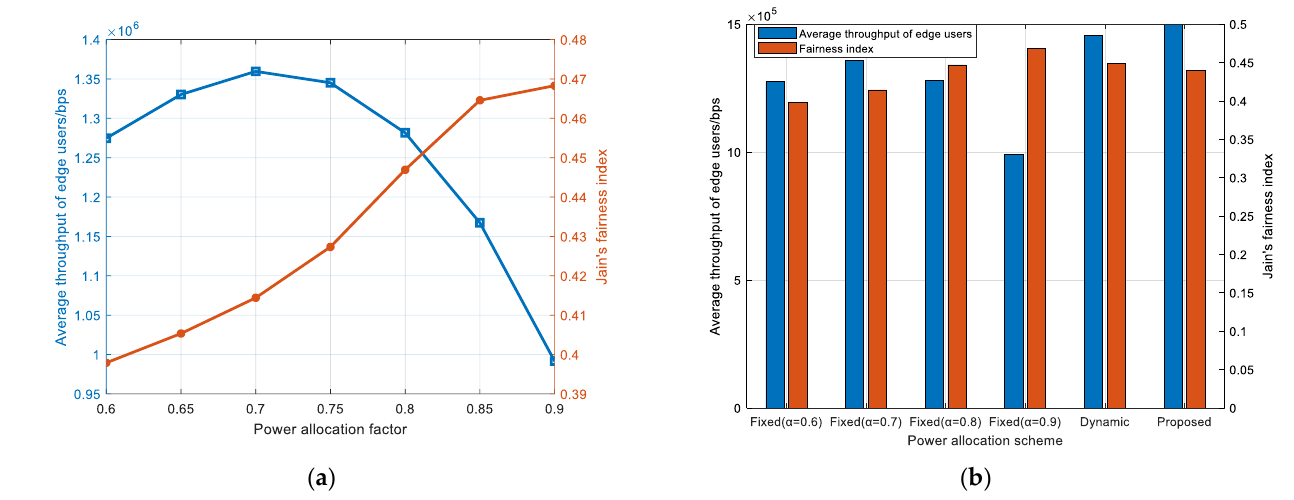
Figure 4. Throughput performances of edge users and fairness index: ( a ) under random user pairing scheme with different power allocation factor; ( b ) under different power allocation schemes.